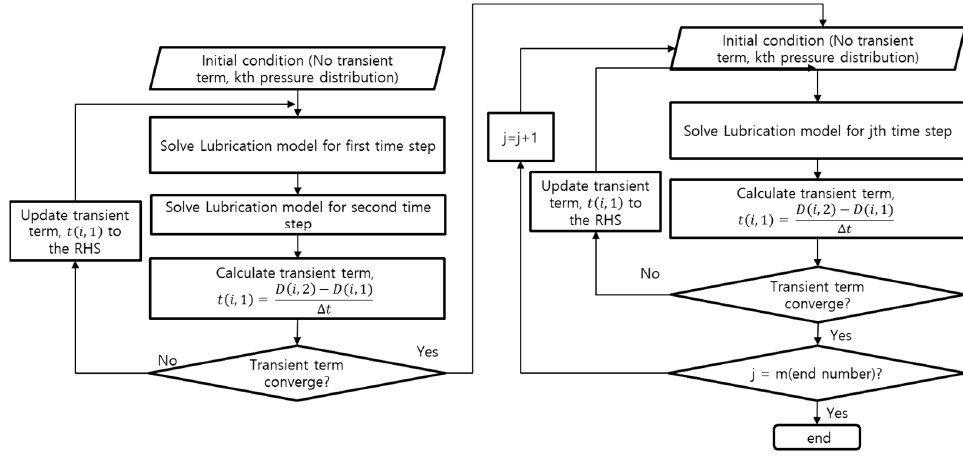
Figure 5. Flow chart of the lubrication model.